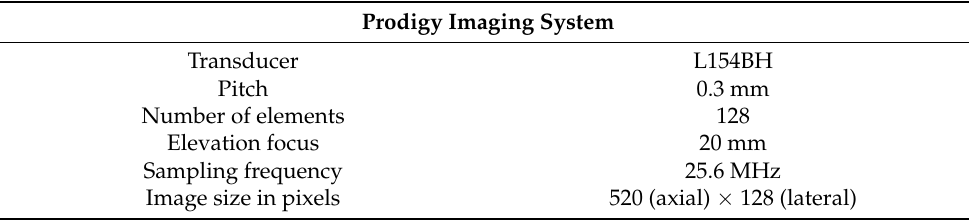
Figure 3. The curve of singular value of the in vivo experimental data and the corresponding low-order and high-order threshold for SVD clutter filtering. Table 2. The imaging parameter of in vivo